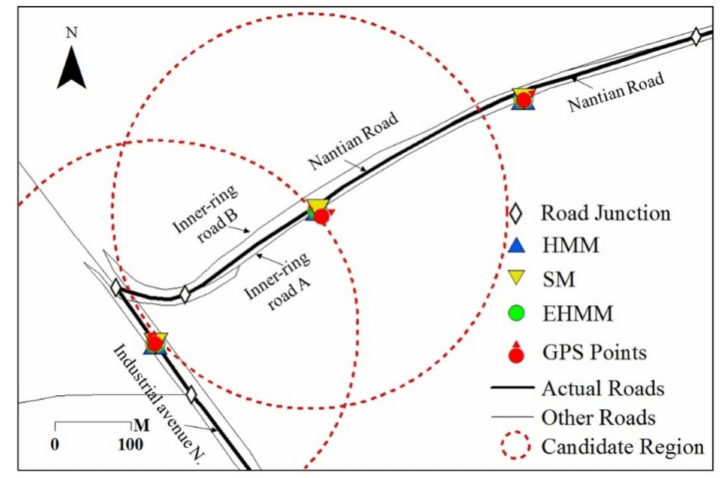
Figure 8. Weakening of the topological constraint with an increase in the sampling